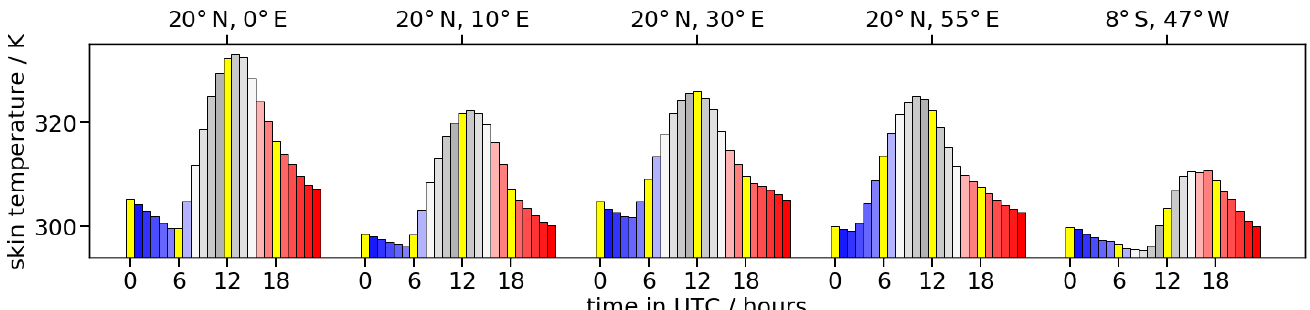
Figure 4. Daily course of the skin temperature (from ECMWF ERA5) for five different locations (see marker in Figure 3); the yellow columns represent the temperatures at 0, 6, 12 and 18